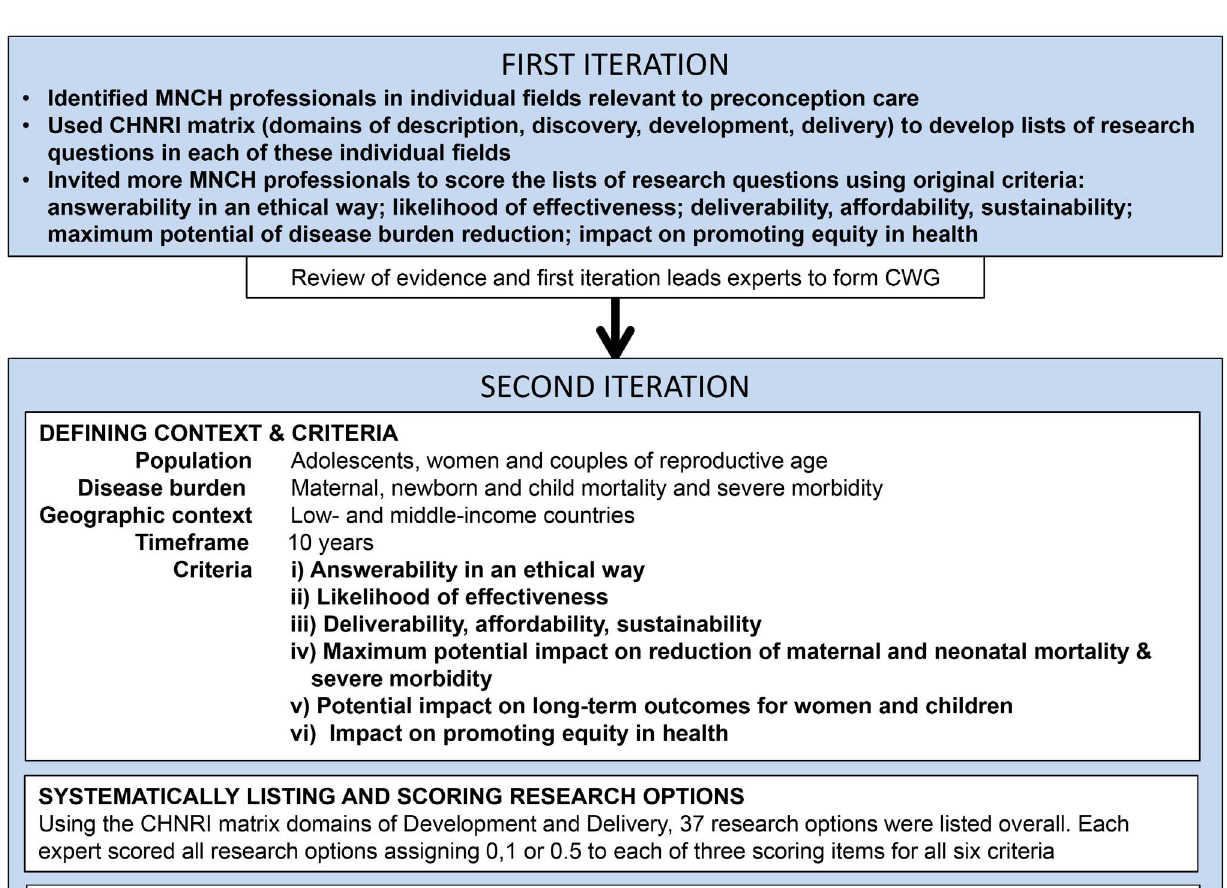
Figure 1.Conceptual framework. Overview of the key steps in this adaptation of the CHNRI methodology.